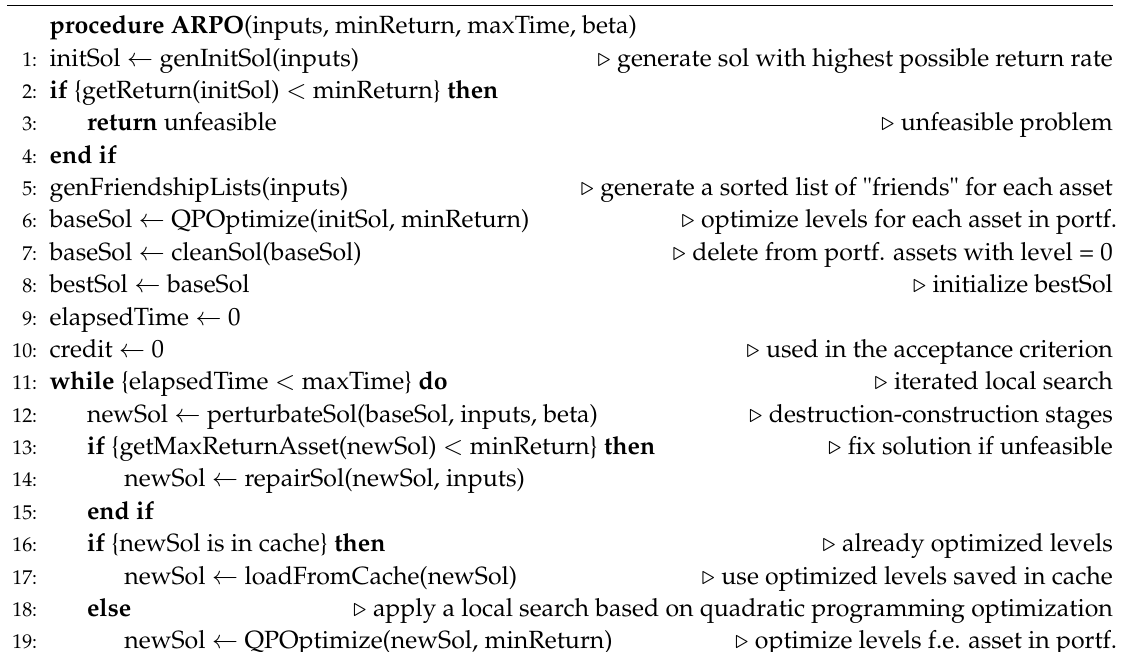
Algorithm 1 Main procedure of the ARPO algorithm (ILS